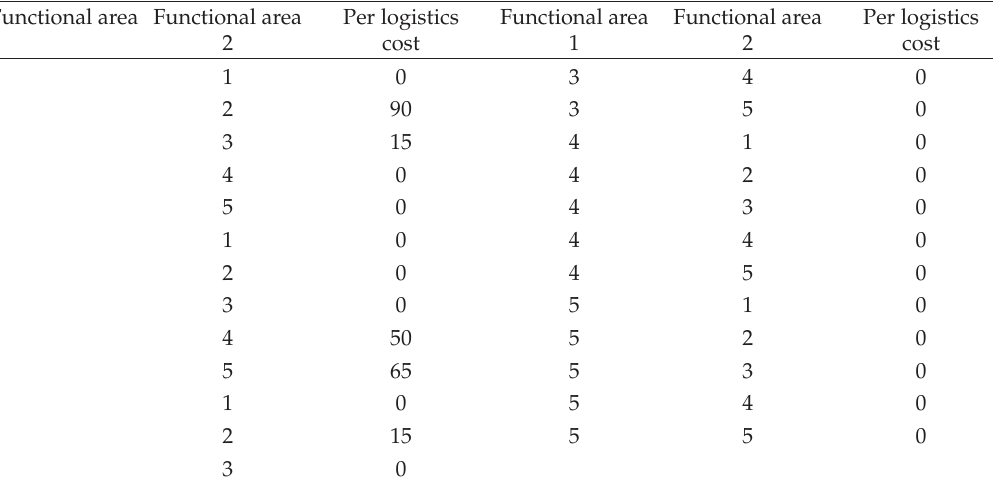
Table 2: From-to table between functional areas.